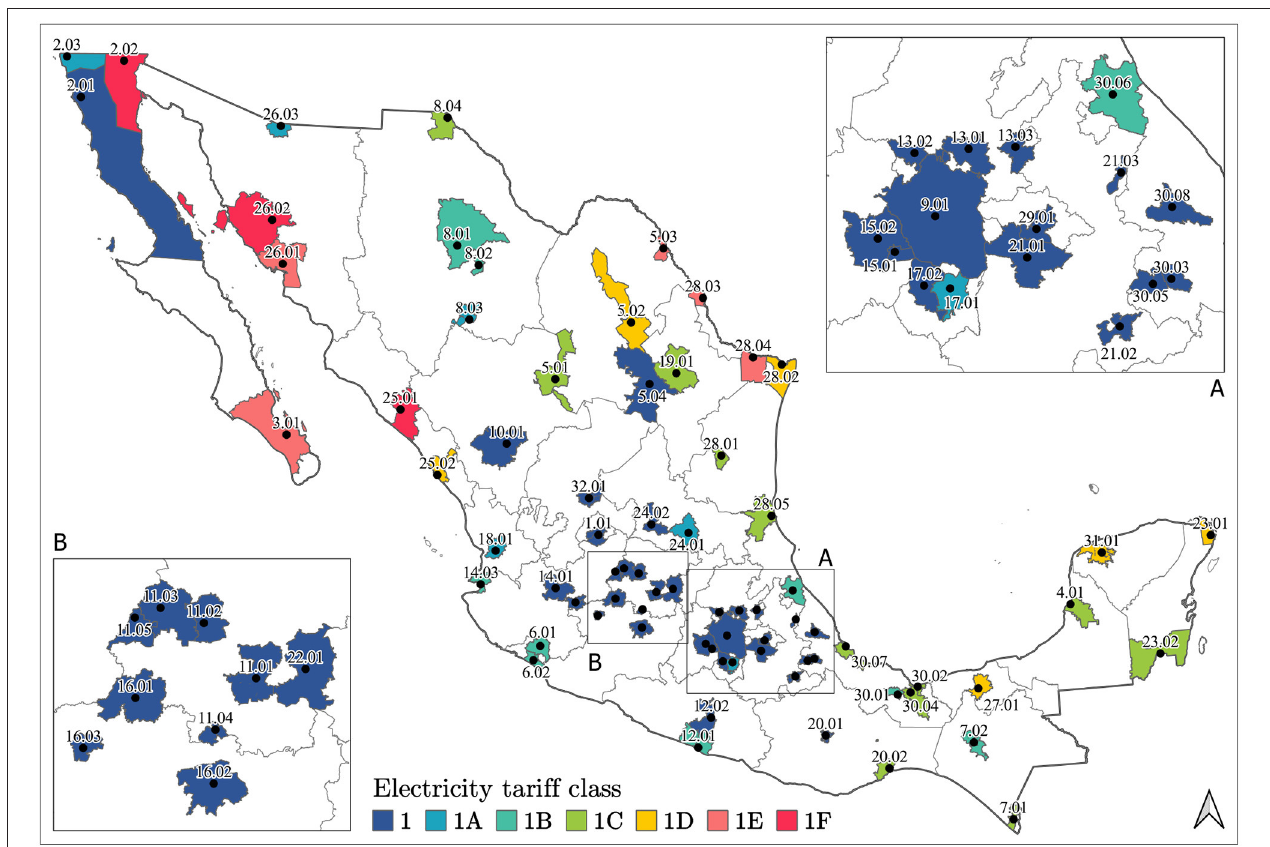
Table A in the Supplementary Material lists the key information of the metropolitan areas in this